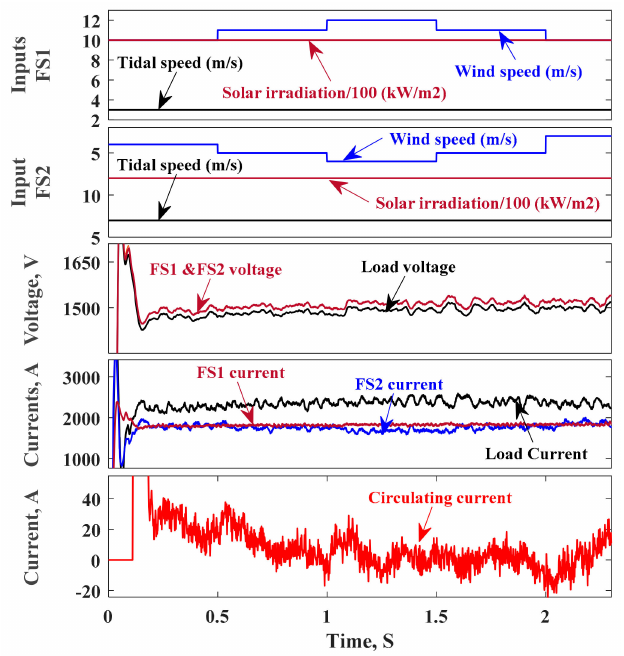
Figure 22. Simulation results of two floating energy units with